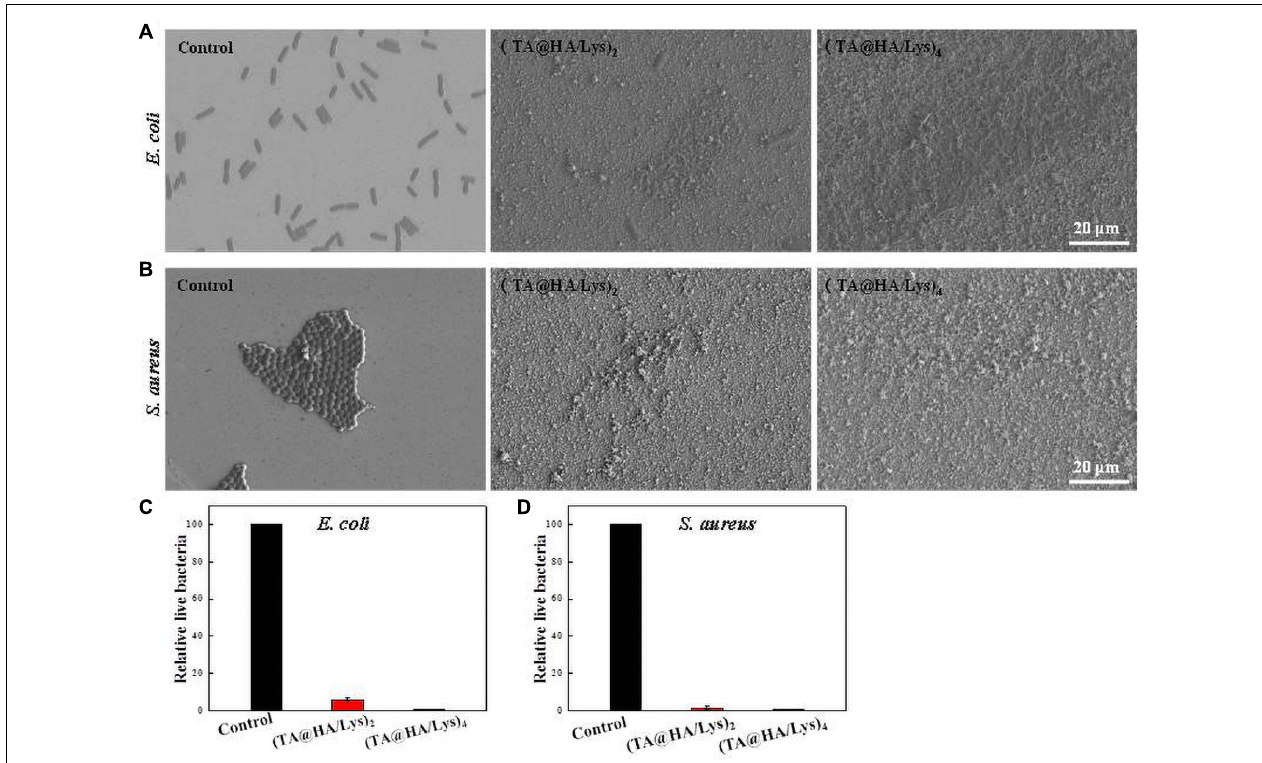
FIGURE 7 | SEM images of (A) Escherichia coli and (B) Staphylococcus aureus after exposure to control (glass coverslips, left row), (TA@HA/Lys) 2 (middle row), and (TA@HA/Lys) 4 (right row) coatings. Relative live bacteria number of (C) E. coli and (D) S. aureus in above films (the control group as a reference). All images were using the same scale bar.